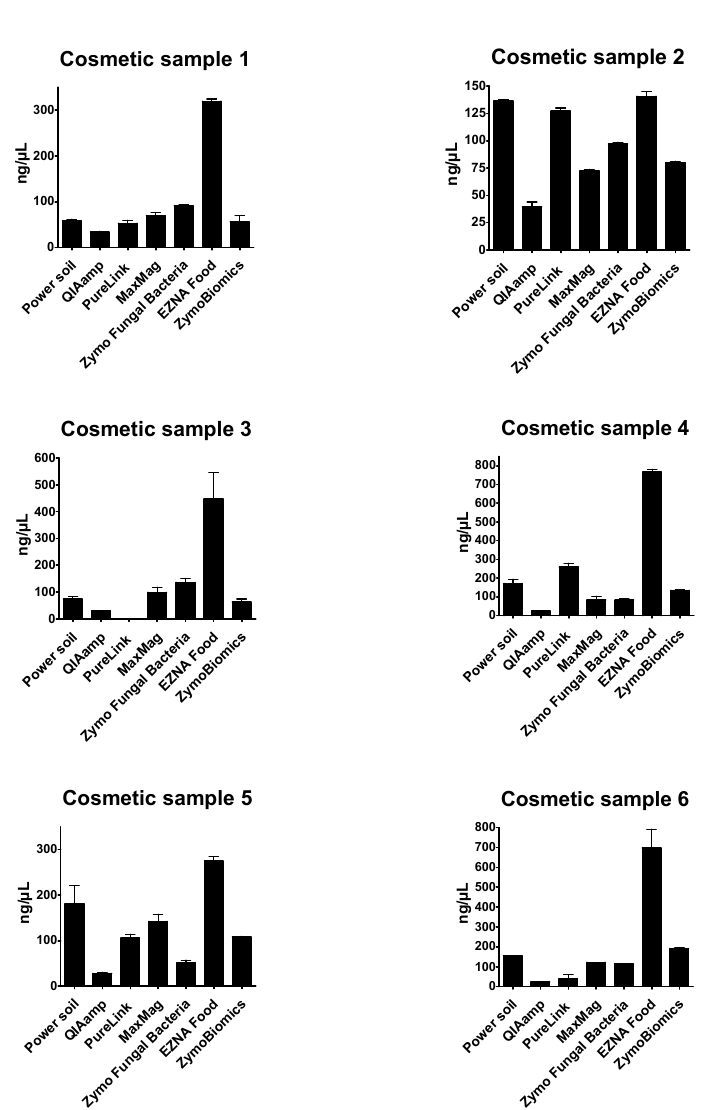
Figure 2. Comparison between DNA recovery rates reached using the seven methods tested on Lactobacillus rhamnosus (10 × 10 9 ) spiked samples. On the X axis is the name of the commercial kit employed, while on the Y axis, the DNA concentration is expressed in ng/μL.